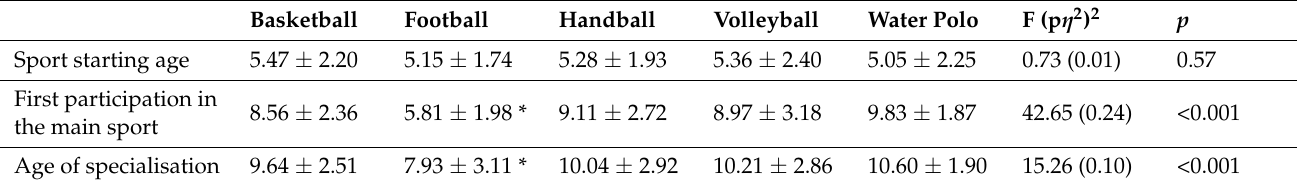
Table 1. Ages of first participation in sport (general and specific) and specialisation according to the